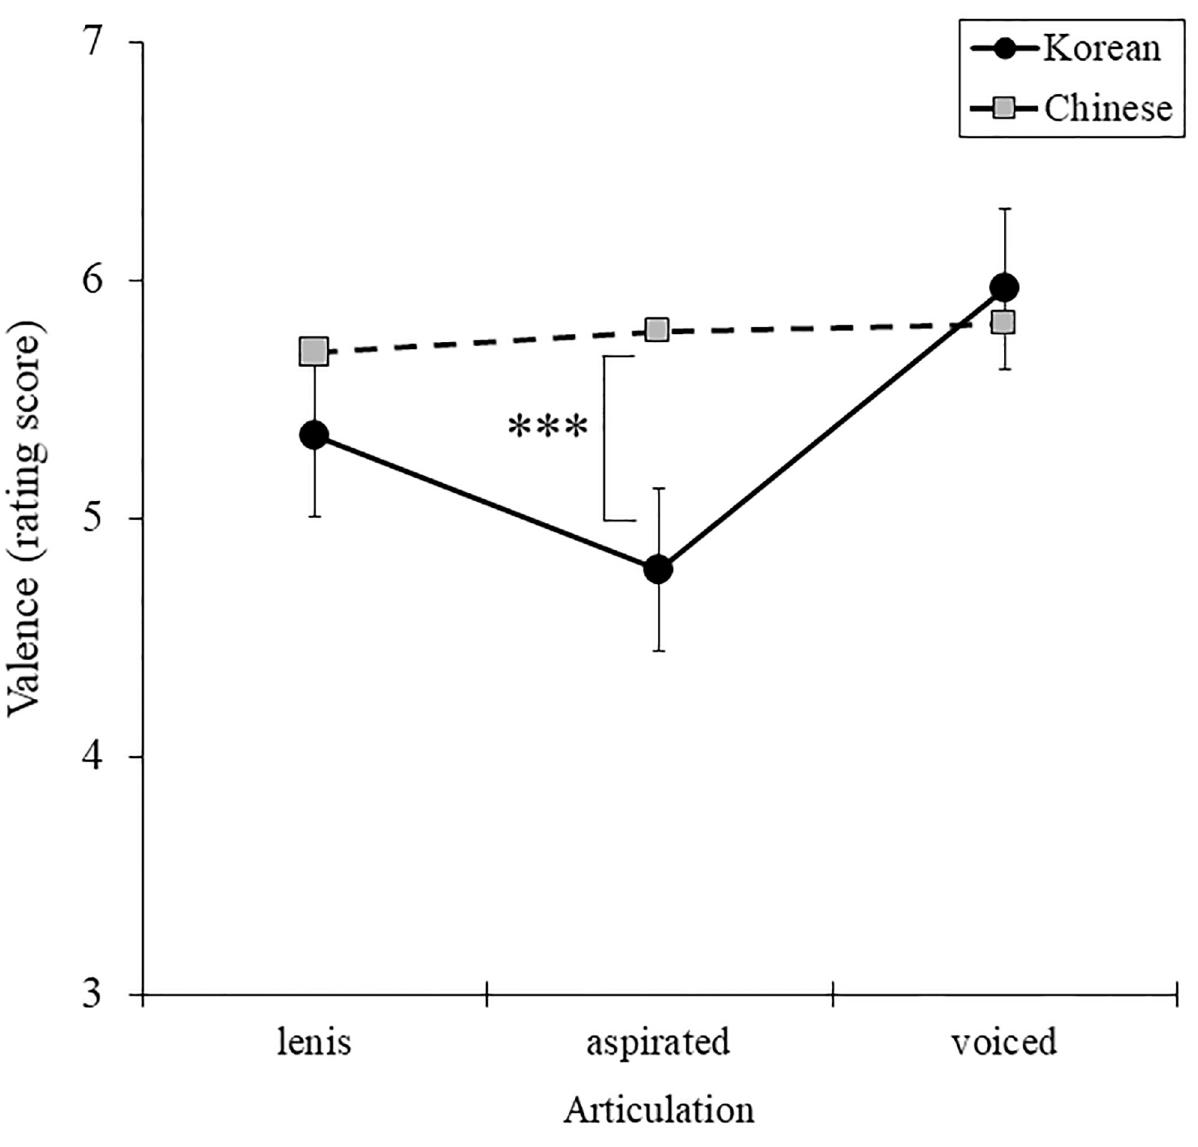
Fig 3. Comparison of valence for nationality groups in